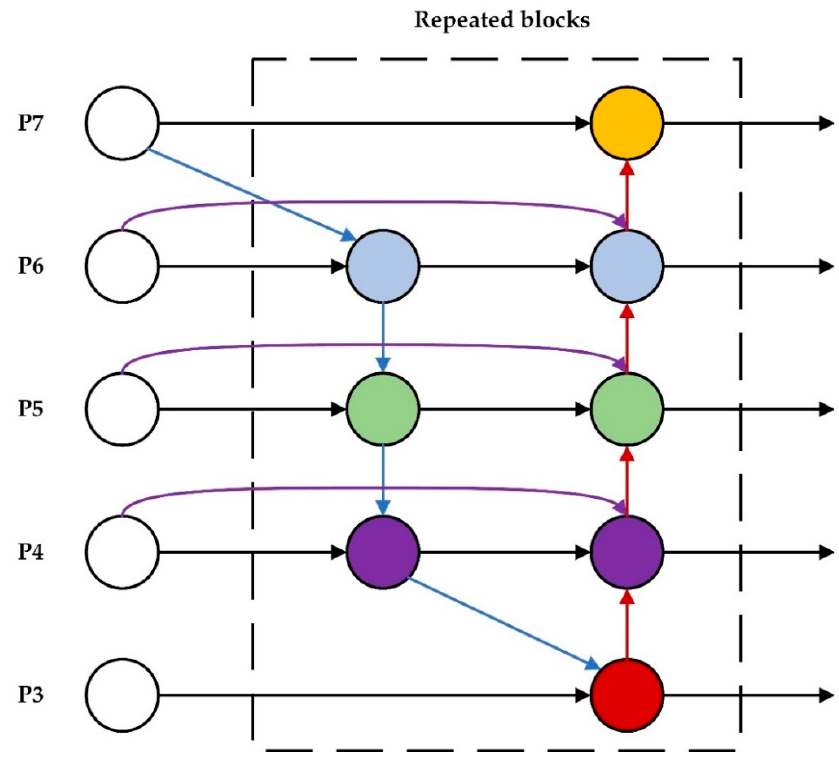
Figure 9. BiFPN implements two optimizations for cross-scale connections.